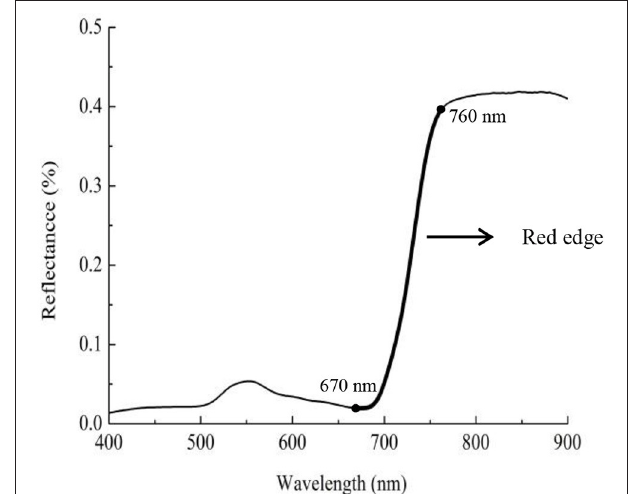
FIGURE 2 | Schematic representation of red edge reflectance curve.